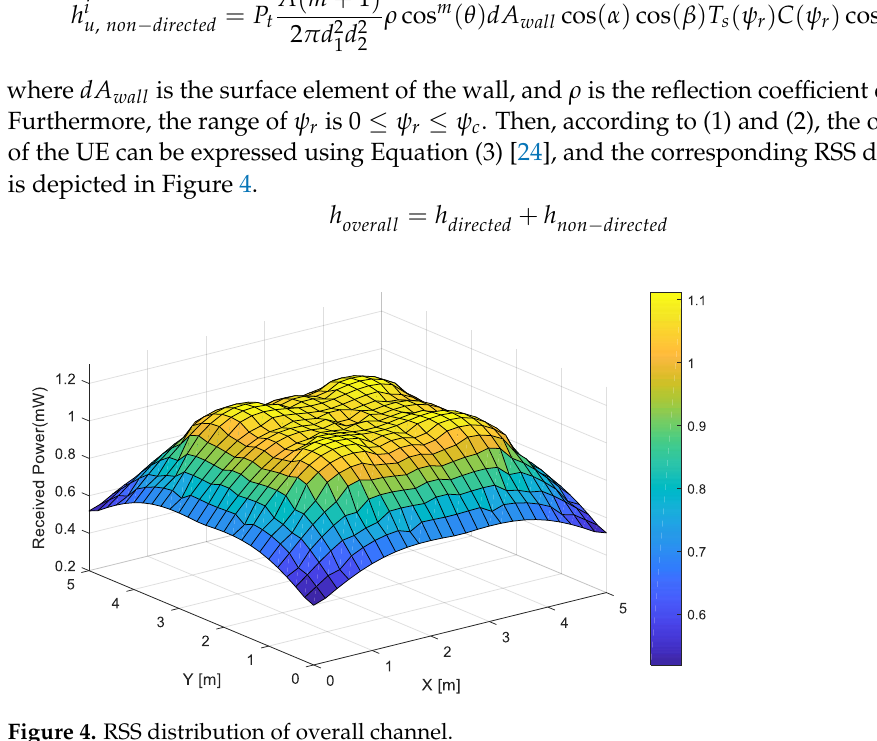
Figure 4. RSS distribution of overall channel.